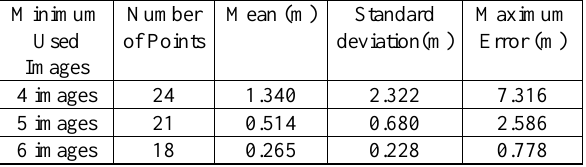
Table 2. Mapping accuracies using different number of images